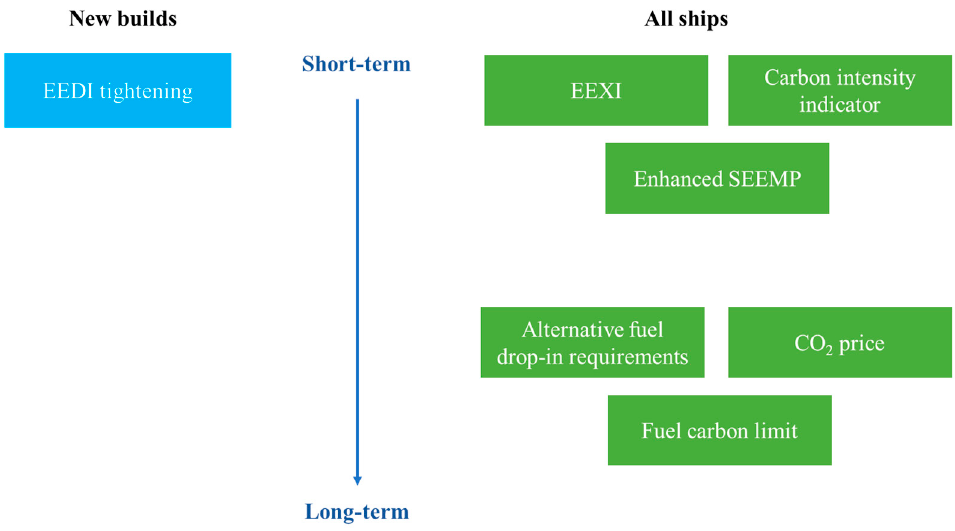
Figure 1. Indicative timeline for developing and implementing possible global policy measures.